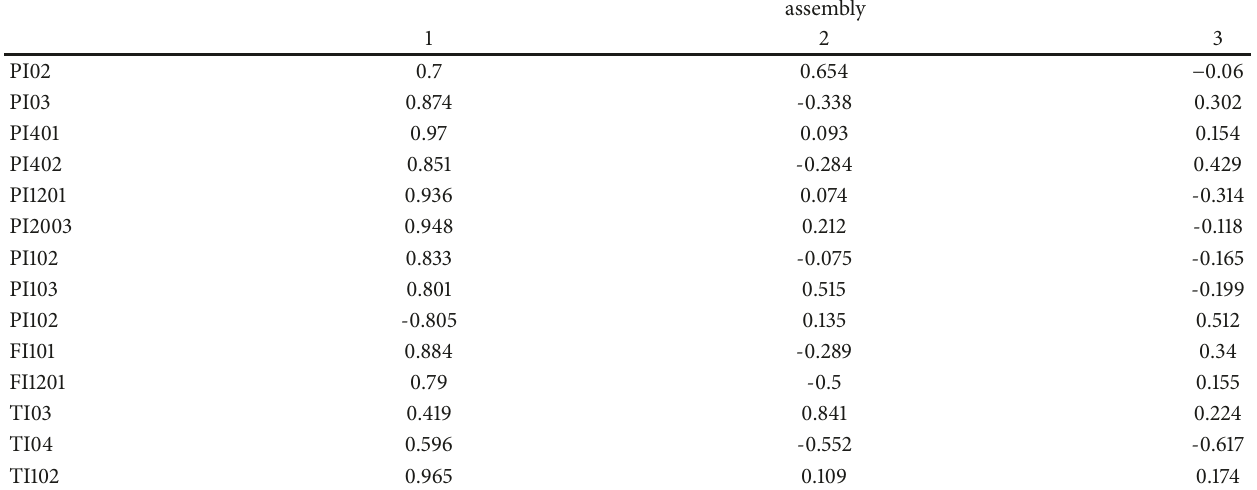
Table 6: Principal component load vector.